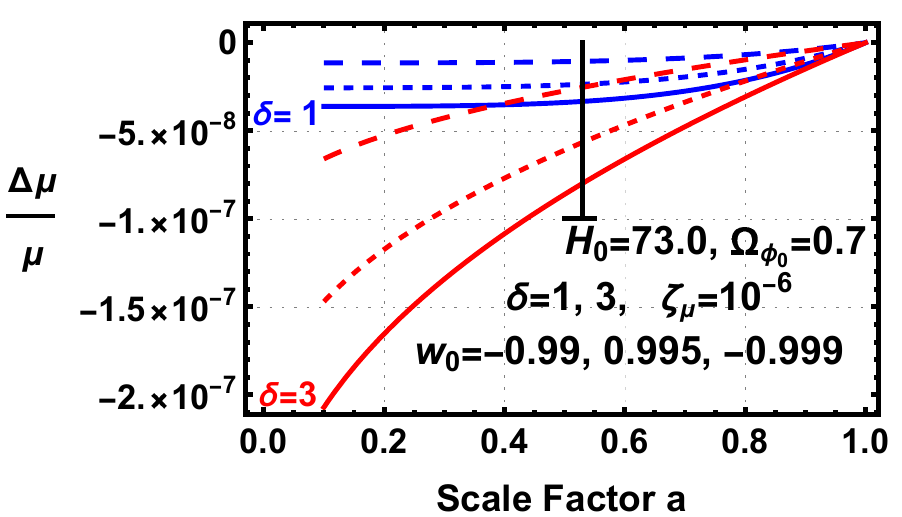
∆ µ Figure 16. The evolution of for δ = 1 and 3 for all three values of w 0 . The error bar at a scale µ factor of 0.5303 is the 2 σ constraint on the temporal variation of µ